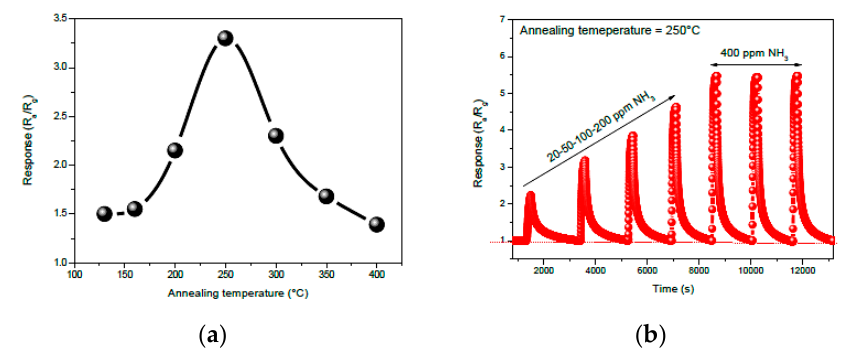
Figure 2. ( a ) Effect of annealing temperature on the response towards 50 ppm NH 3 at the working temperature of 130 °C; ( b ) Dynamic responses of annealed sensing film at 250 °C when exposed to different NH 3 concentration in the range 25–400 ppm at the working temperature of 130